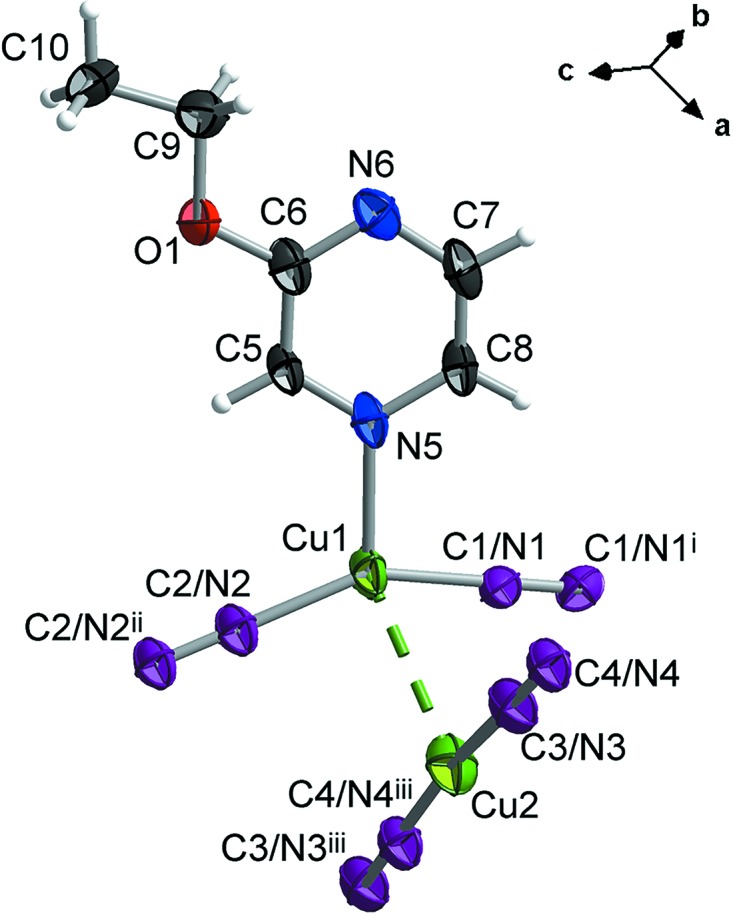
A fragment of the crystal structure of the title compound, with displacement ellipsoids drawn at the 65% probability level [symmetry codes: (i) −x + 1, y, −z + ; (ii) −x + 1, −y, −z + 1; (iii) x, y − 1, z]. Four of the cyanide ligands (C1/N1—C1/N1i, C2/N2—C2/N2ii, C3/N3—C4/N4 and C4/N4iii—C3/N3iii) are disordered over two sites with occupancies of 0.5. The Cu⋯Cu contact is shown as a dashed line.